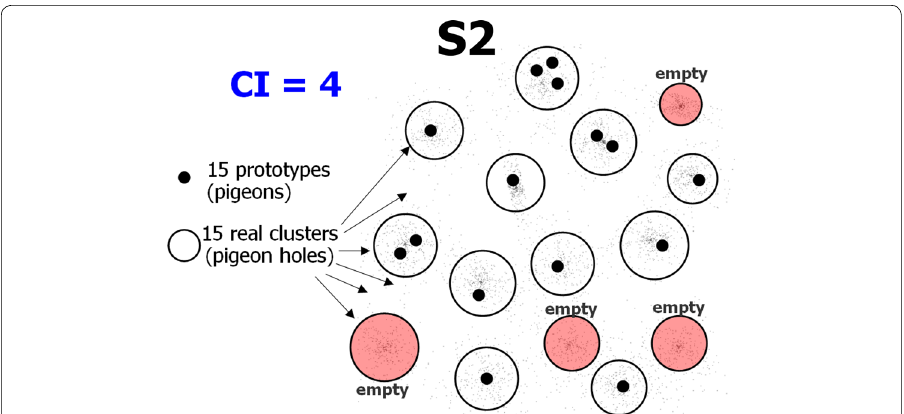
Fig. 1 Illustration of the clustering problem using a pigeon-hole principle with dataset S 2 . The circles represent the location of the ground truth clusters (pigeon holes), and the black dots the prototypes. Centroid index is calculated as how many cluster-level errors (either empty slots or over-crowded slots) there